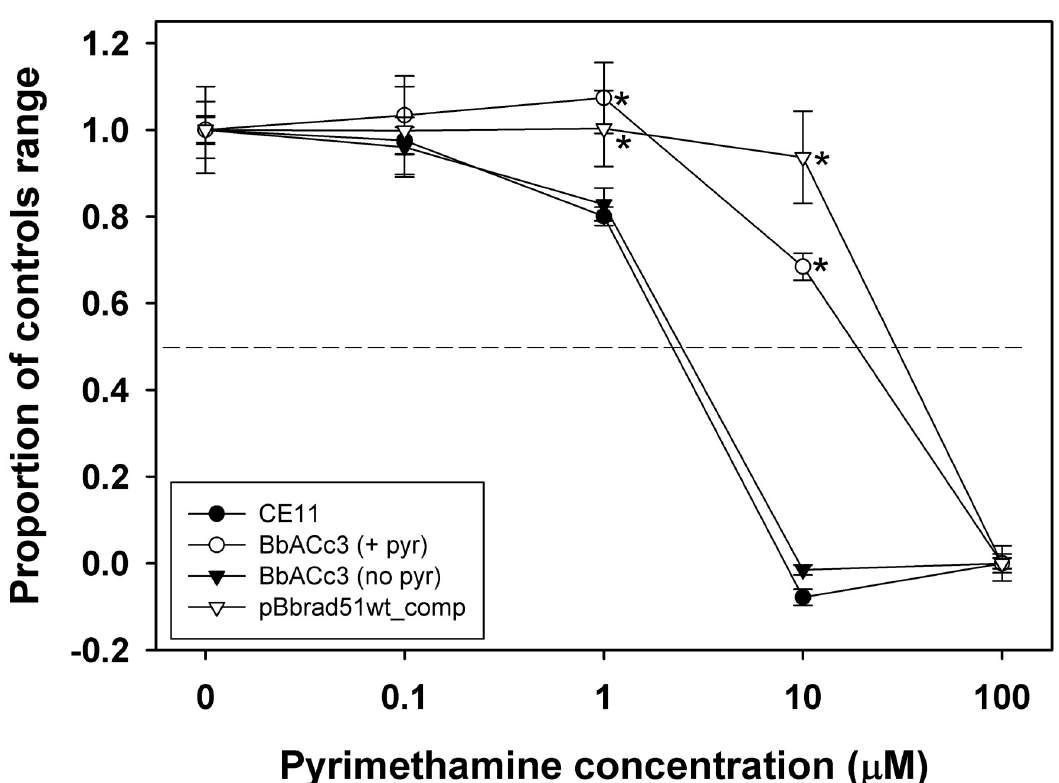
Fig 6. Pyrimethamine-sensitivity in the presence of BbACc3. Sensitivity profiles are shown for B . bovis CE11, and CE11 transformed with BbACc3 or pBb rad51 wt_comp. The presence of either the artificial chromosome, BbACc3, or the integrated construct, pBb rad51 wt_comp, results in significant resistance to pyrimethamine. The IC 50 value for each line was approximately 2.2 μ M for CE11, 29 μ M for CE11/pBb rad51 wt_comp, 19 μ M for CE11/BbACc3 (maintained under constant pyrimethamine pressure; BbACc3 (+pyr)), and 2.5 μ M for CE11/BbACc3 three weeks after relief of drug pressure (BbACc3 (no pyr)). Asterisks indicate samples whose values differed statistically significantly (all values p < 0.001) from those of CE11 at each concentration, based upon one-way ANOVA using CE11 as control